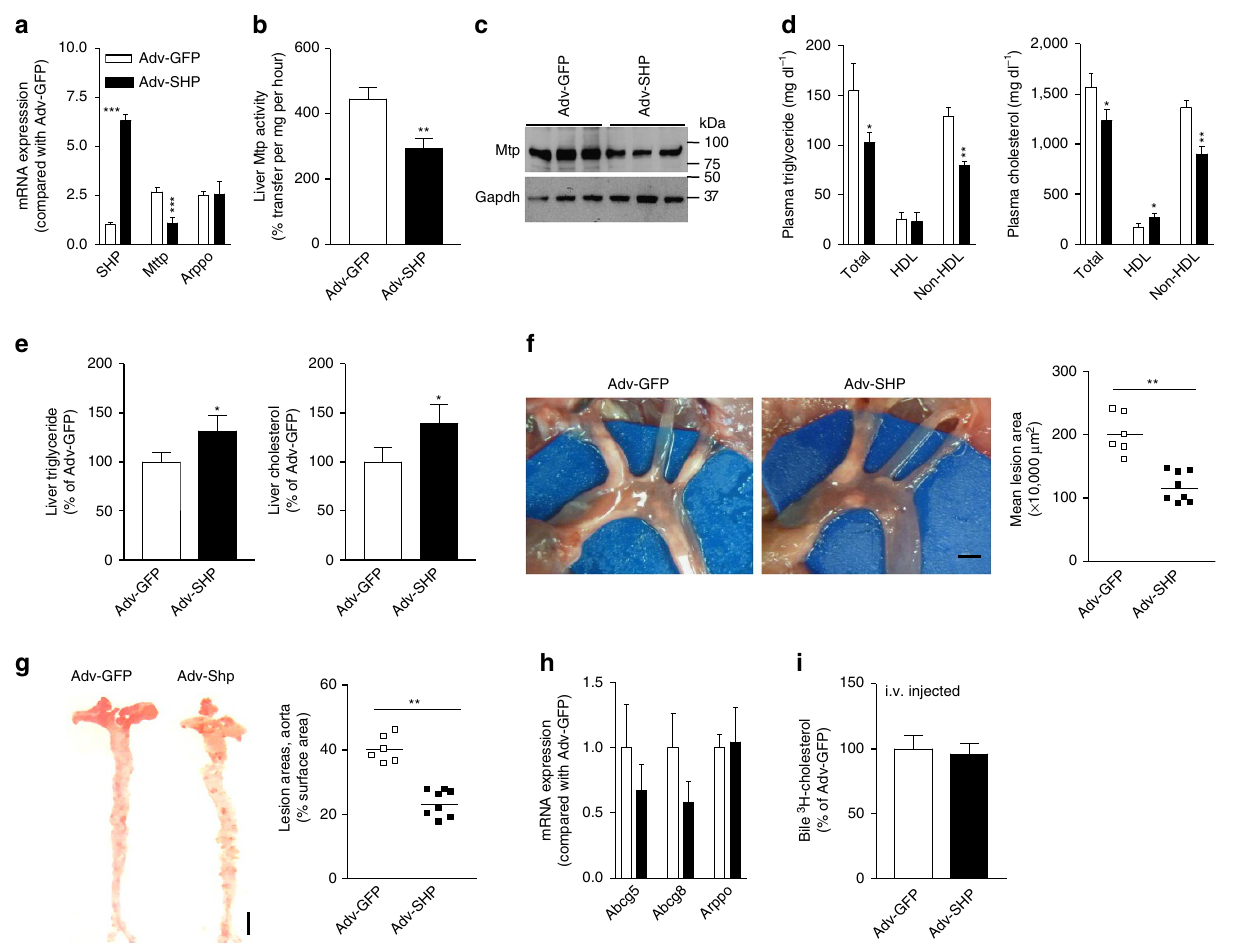
Figure 5 | Effects of hepatic Shp expression in L-Bmal1 (cid:2) / (cid:2) Apoe (cid:2) / (cid:2) mice. L-Bmal1 (cid:2) / (cid:2) Apoe (cid:2) / (cid:2) mice (male, 12 weeks) were intravenously (i.v.) injected (1 (cid:3) 10 11 p.f.u. per mouse) with adenoviruses expressing SHP (Adv-SHP, black square) or GFP (Adv-GFP, white square) and fed a Western diet for 4 weeks. ( a ) Hepatic mRNA levels of different genes. ( b , c ) Livers from these mice were used to measure MTP activity ( b ) and protein ( c ). ( d ) Triglyceride and cholesterol were measured in total plasma and different lipoprotein fractions. ( e ) Lipids were measured in the livers. ( f ) The aortic arches were exposed, photographed (left) and lesion areas were quantified (right). Scale bar, 2mm. ( g ) Aortas were dissected, stained with Oil Red O (left), and lesion areas were quantified (right) with Image-Pro. Scale bar, 5mm. ( h ) Hepatic Abcg5 and Abcg8 mRNA levels were unaltered by Shp overexpression. ( i ) Excretion of injected 3 H-cholesterol to the bile was unaffected by Shp expression ( n ¼ 4 per group). Data in a , b , d , e , h and i were evaluated by the unpaired Student’s t -test. Data in